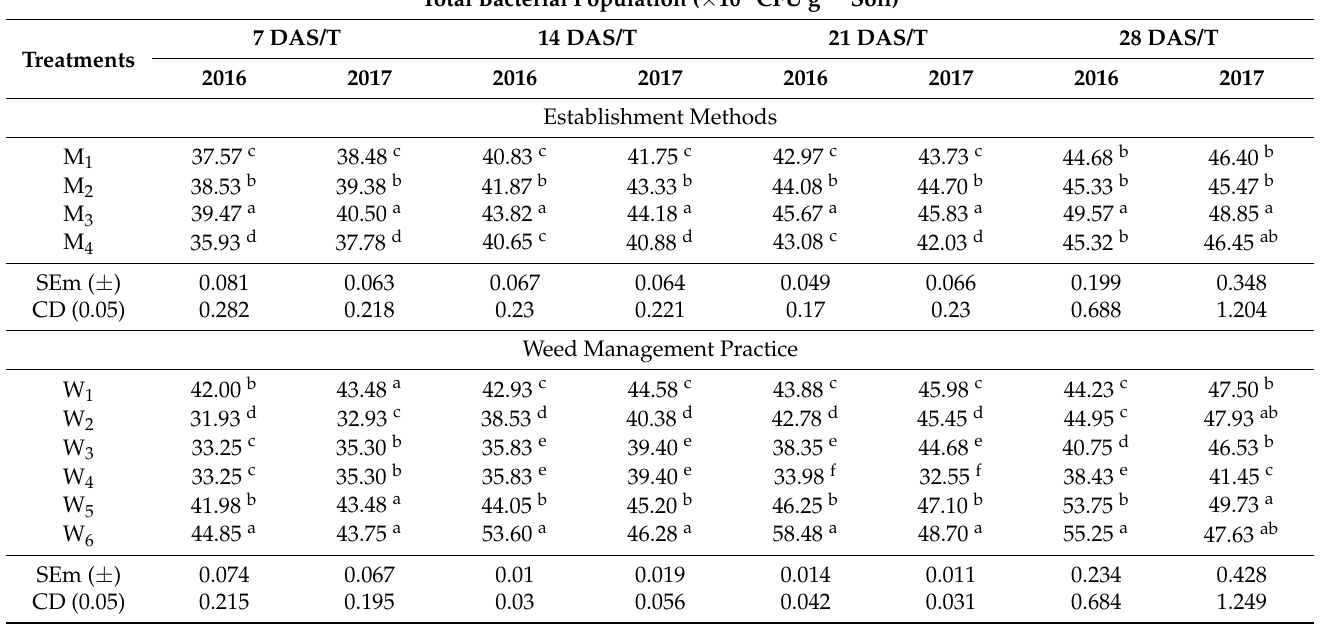
Table 5. Total bacterial population ( × 10 6 CFU g − 1 soil) in rice soil as influenced by crop establishment methods and weed management